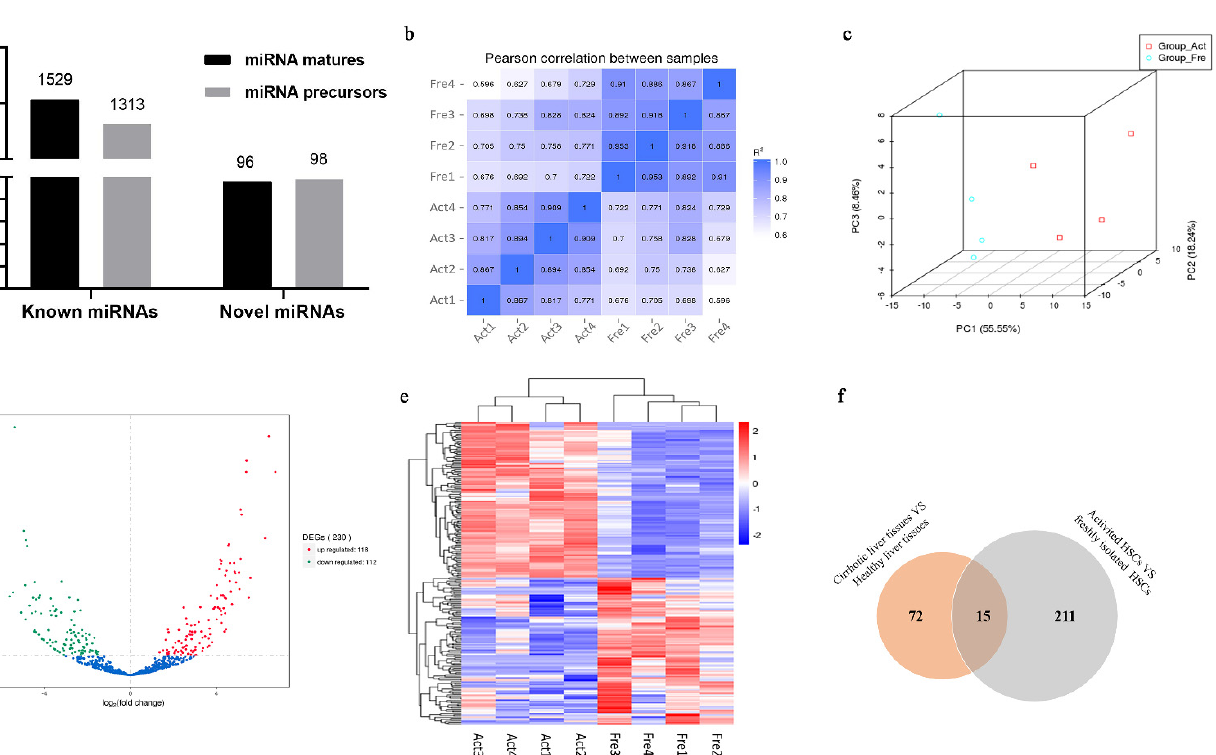
Figure 2. Identification of HSCs isolated from human liver tissues. ( a ) Autofluorescence of cytoplas- mic vitamin A in freshly isolated HSCs. ( b ) Immunofluorescence staining of culture-activated HSCs and LX-2 cells for α -SMA (magnification: 400×; in ( a , b )). α -smooth muscle actin, α -SMA; hepatic stellate cells, HSCs.